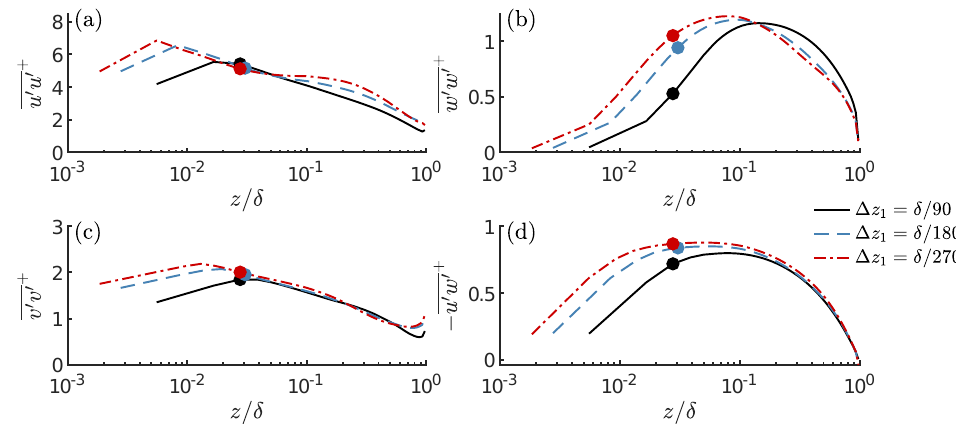
+ + + + , ( b ) w (cid:48) w (cid:48) , ( c ) v (cid:48) v (cid:48) and ( d ) u (cid:48) w (cid:48) as